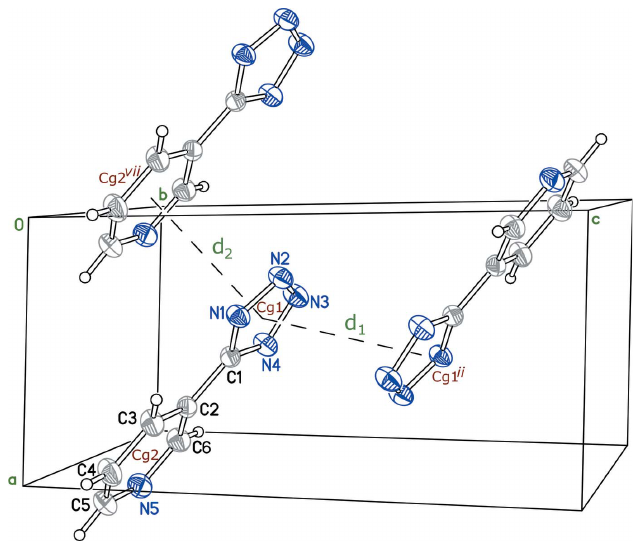
Figure 4 Partial crystal packing, showing (cid:2) – (cid:2) interactions between tetrazole and